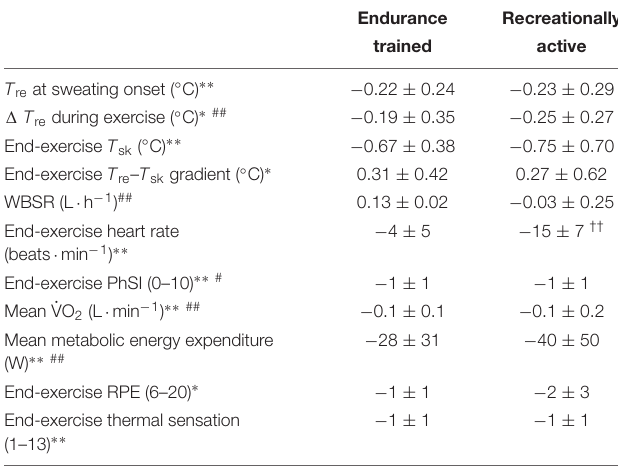
TABLE 2 | Effect of 6-day post-exercise hot water immersion heat acclimation on thermal, cardiovascular, metabolic, and perceptual responses at rest and to